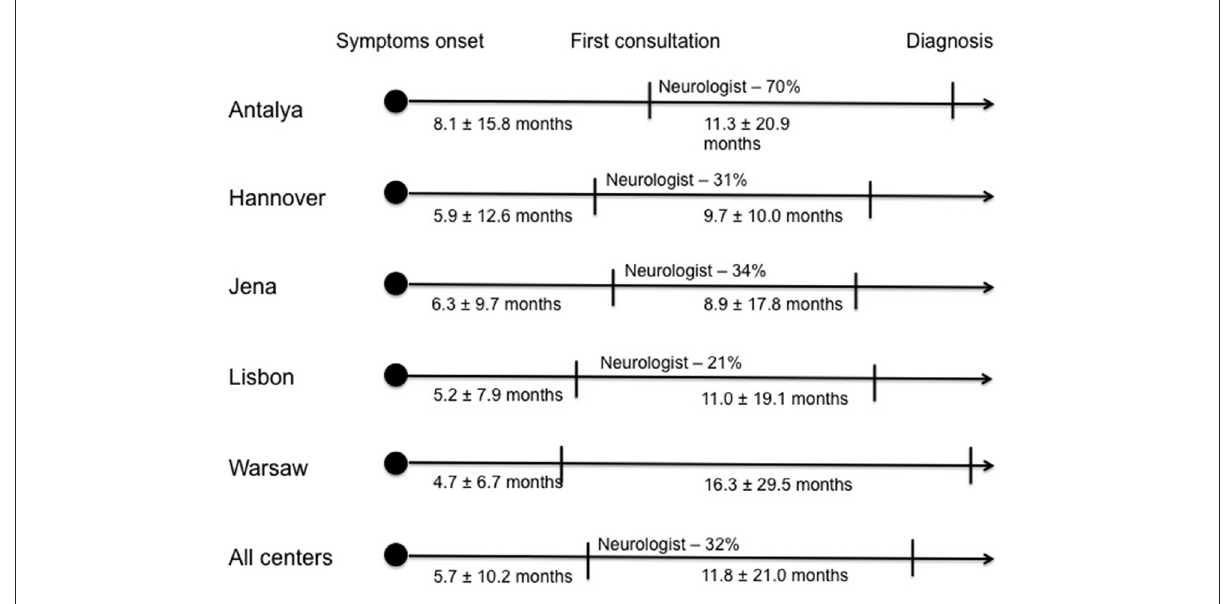
FIGURE1 Diagnostic pathway of ALS patients in each center: Time from first symptom onset to first medical evaluation and time from first medical evaluation to final diagnosis; proportion of Neurologists who observed the patient at first medical evaluation.